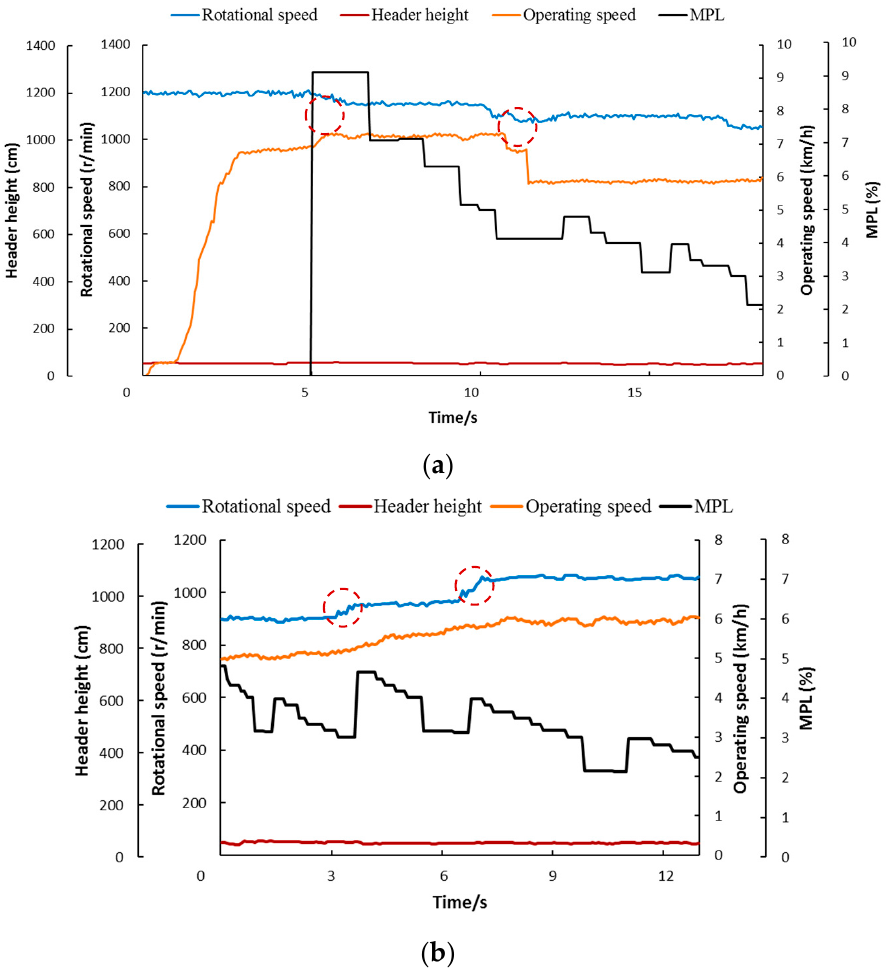
Figure 10. Automatic adjustment of pulling rollers under a load. ( a ) Regulation process of the corresponding outputs when the maize picking loss rate was high. ( b ) Regulation process of the corresponding outputs when the maize picking loss rate was in the allowable range.